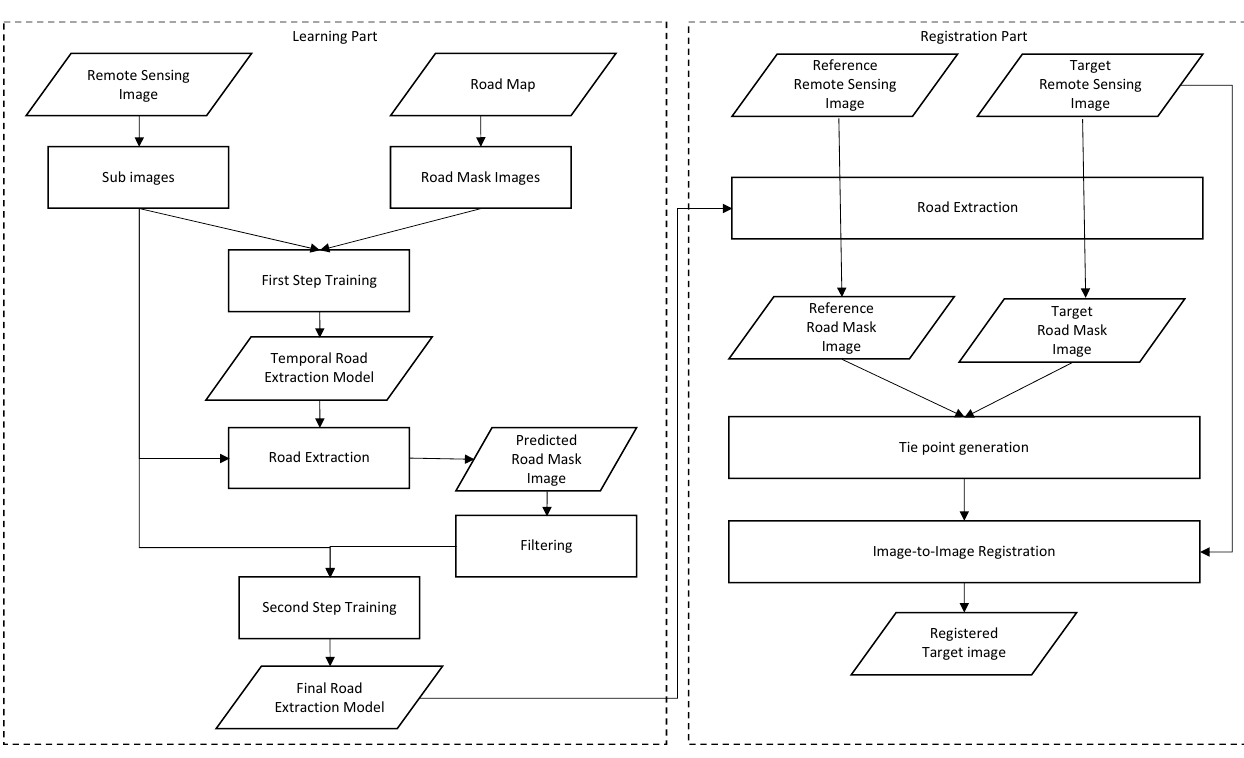
Figure 1. Overall process flow of proposed method.